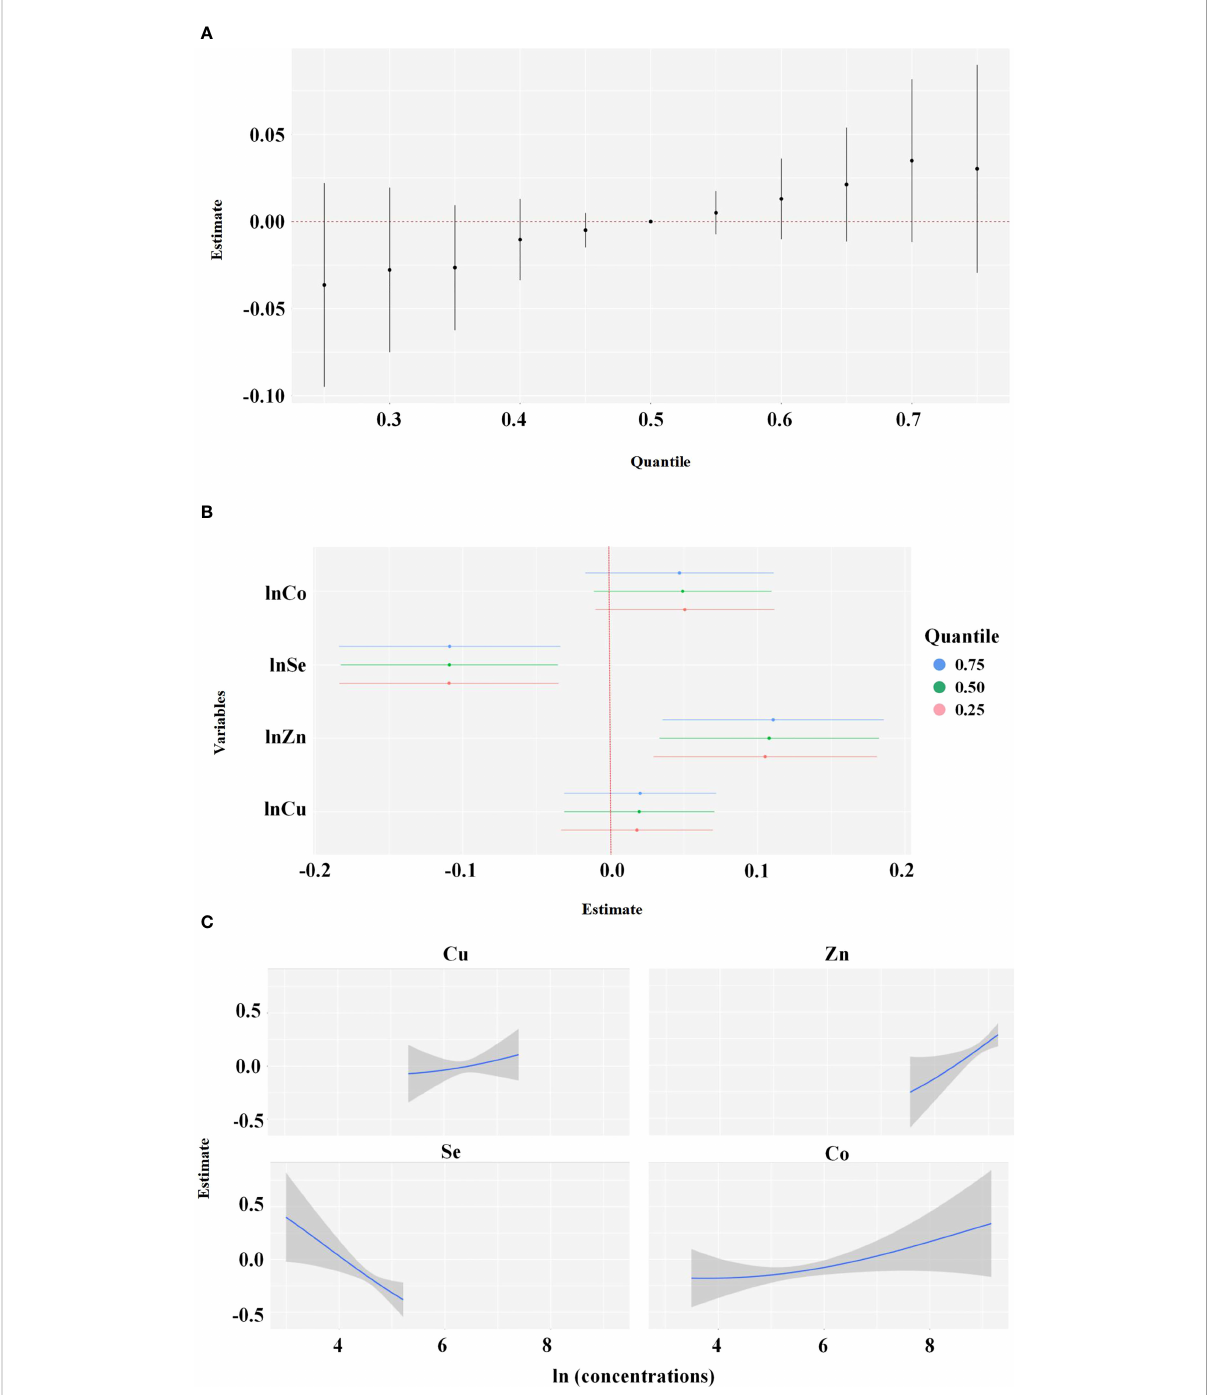
FIGURE 1 Joint effect of the Cu, Zn, Se, Co in blood on early embryonic arrest by Bayesian Kernel Machine Regression (BKMR) Model was adjusted for age, BMI, education, duration of infertility, infertility diagnosis, passive smoking and number of cycles. (A) overall effect of the Cu, Zn, Se and Co (estimates and 95% credible intervals). This plot compared the early embryonic arrest risk when Cu, Zn, Se and Co were at a particular quantile to when they were at the 50th percentile, respectively. (B) independent association of Cu, Zn, Se and Co (estimates and 95% credible intervals). This plot compared the early embryonic arrest risk when Cu, Zn, Se and Co was at the 75th of the metal concentrations with its 25th percentile, when concentrations of all the other metals were held at either the 25th (red line), 50th (green line), or 75th percentile (blue line). (C) Univariate exposure-response function and 95% con fi dence interval (grey part) for Cu, Zn, Se and Co when concentrations of other metals were hold at their median